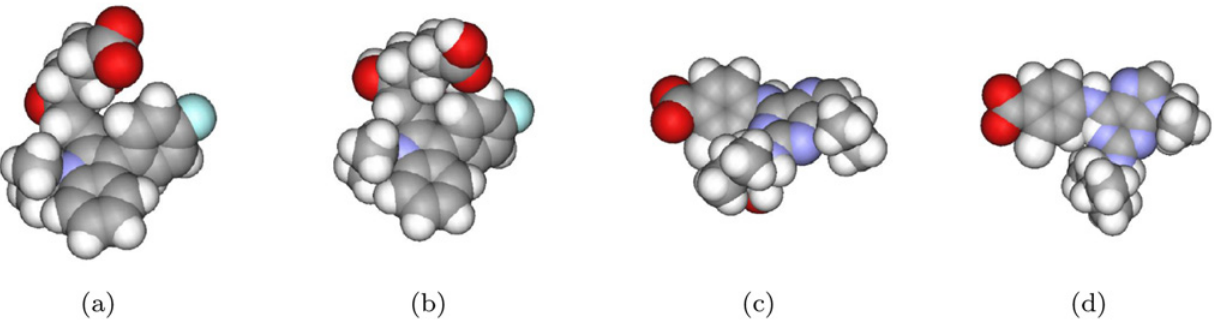
Fig 8. Two different conformations of two ligands: the native state and the minimum energy state. The minimized energy conformation is calculated by MM2 in ChemOffice software. (a) and (b) the native and the minimum energy conformations of 1hwi, respectively; (c) and (d) those of 1v0p.